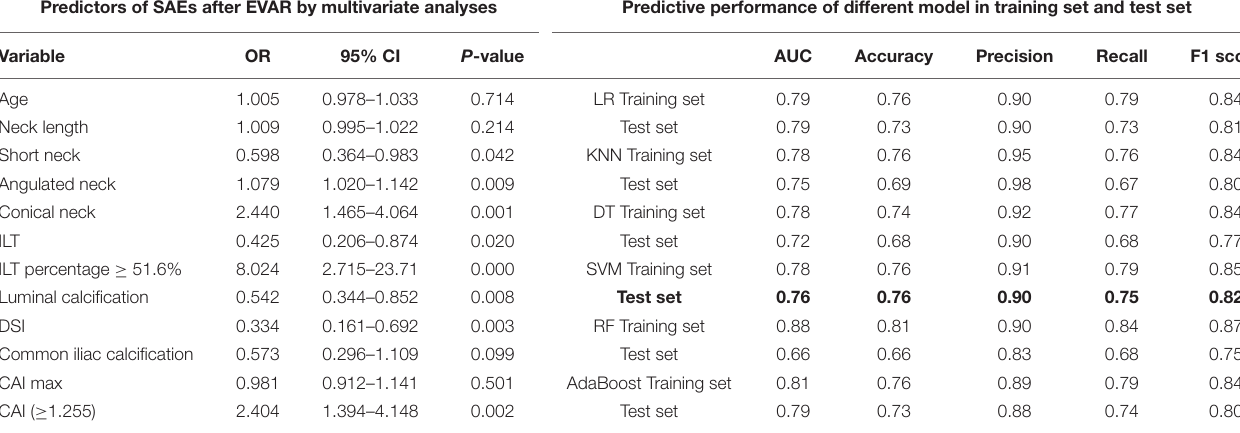
TABLE 2 | Predictors of SAEs after EVAR by multivariate analyses and predictive performance of different models. Predictors of SAEs after EVAR by multivariate analyses Predictive performance of different model in training set and test